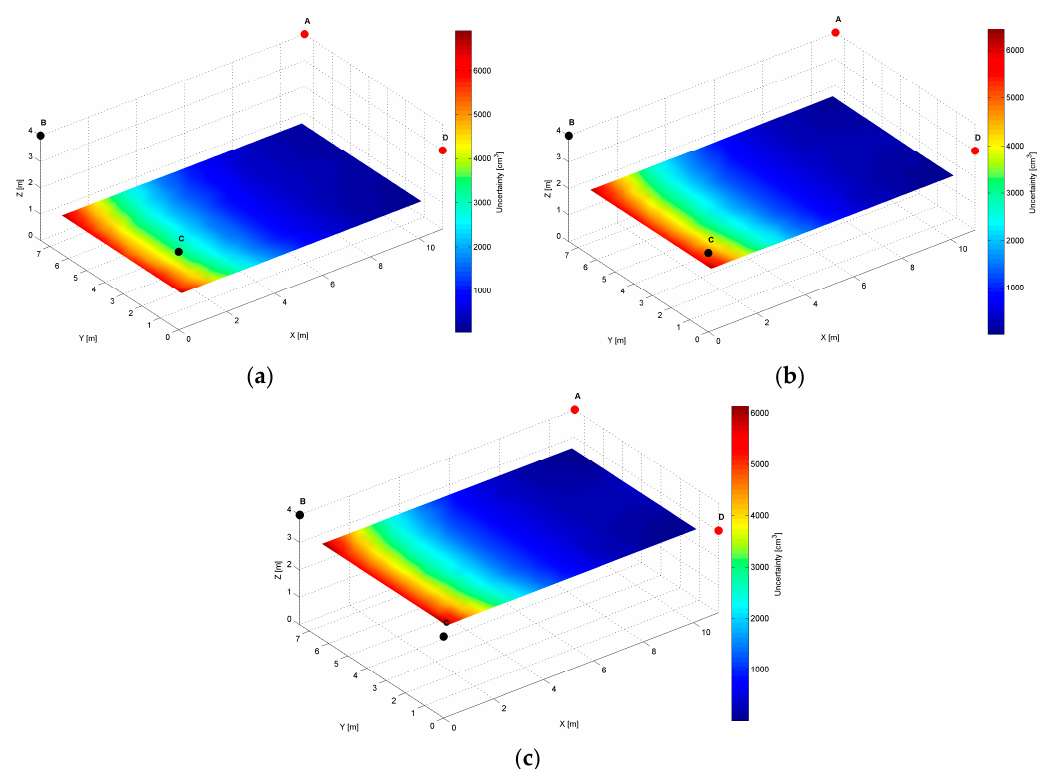
Figure 10. Cross-section ( XY plane) plots of uncertainty-precision distribution for location sensors A and D at ( a ) z = 1.00 m; ( b ) z = 2.00 m; ( c ) z = 3.00 m. All plots are in different colour scales. Table 1. Sensors’ arrangement in simulation and physical experiment.